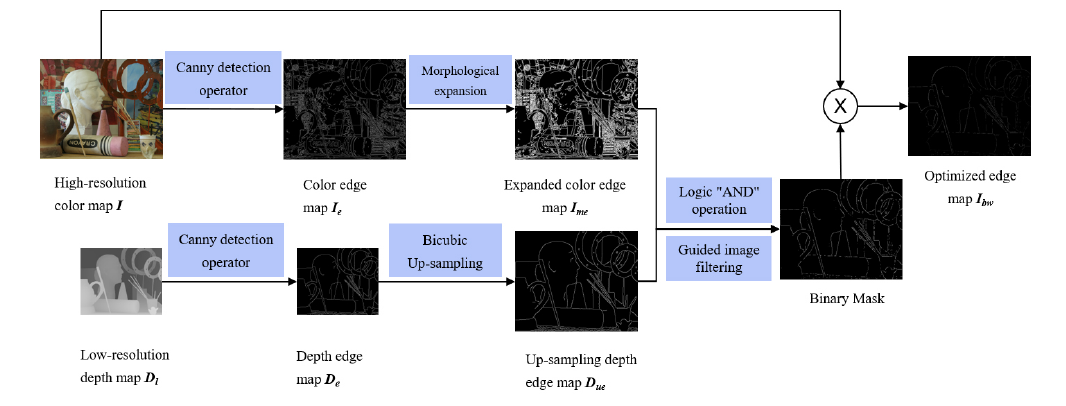
Figure 1. Process of Obtaining the Optimized Color Edge Map I bw .